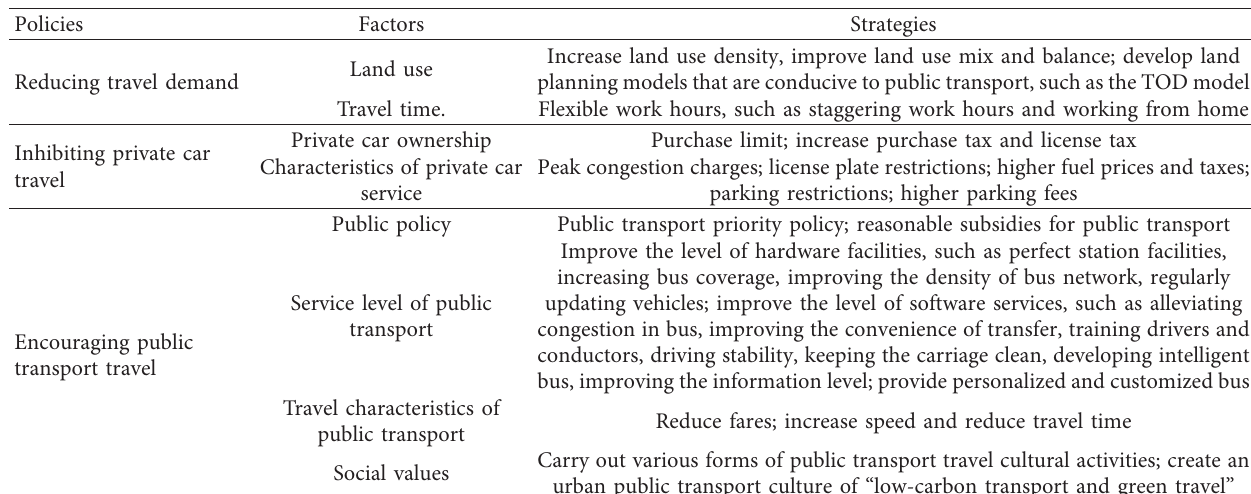
Table 11: Policies to enhance the attractiveness of public